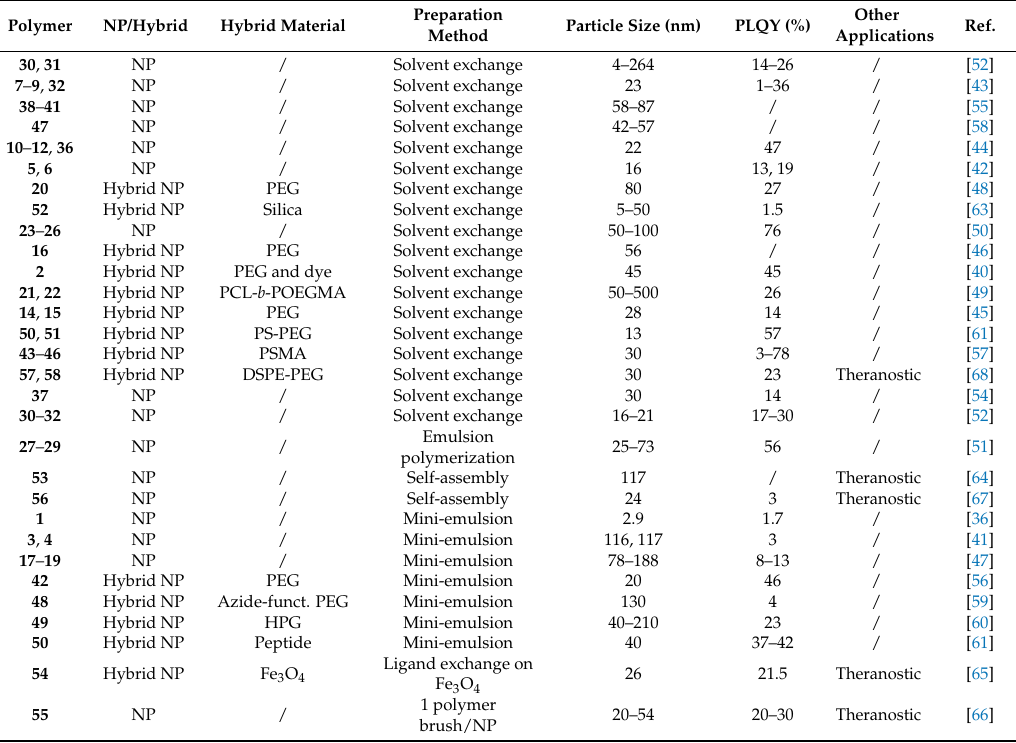
Table 1. Overview of conjugated polymer nanoparticles used in